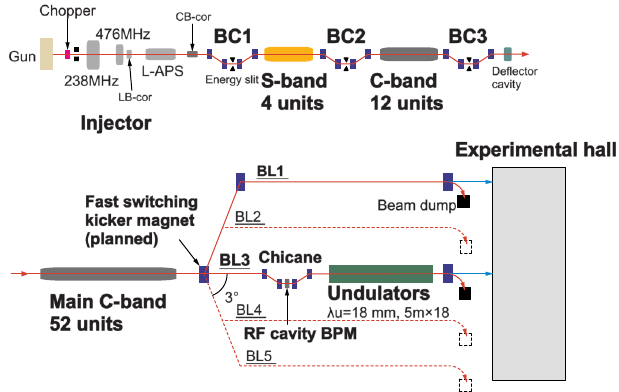
FIG. 2. Schematic view of the SACLA facility. Currently a dc bending magnet is installed at the location of the fast switching kicker